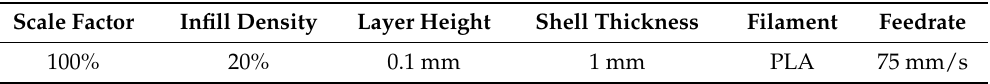
Table 1 . Key parameters used in Cura for slicing the Calibration Cube. Table 1. Key parameters used in Cura for slicing the Calibration